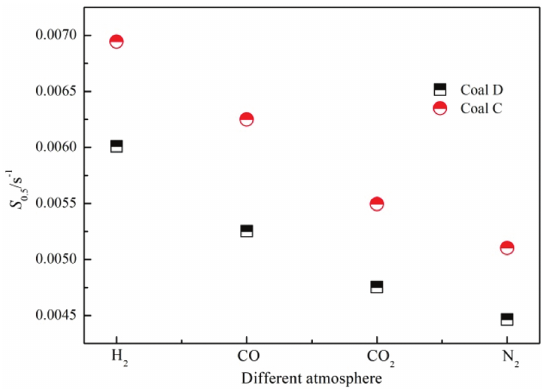
Figure 10: Relationship between pyrolysis atmosphere and pyrolysis